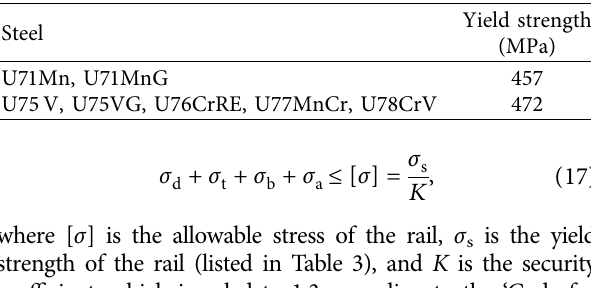
Figure 4: Rotation directions of beams are different due to ec- centric train loads. Table 3: Yield strengths of different kinds of steels for the